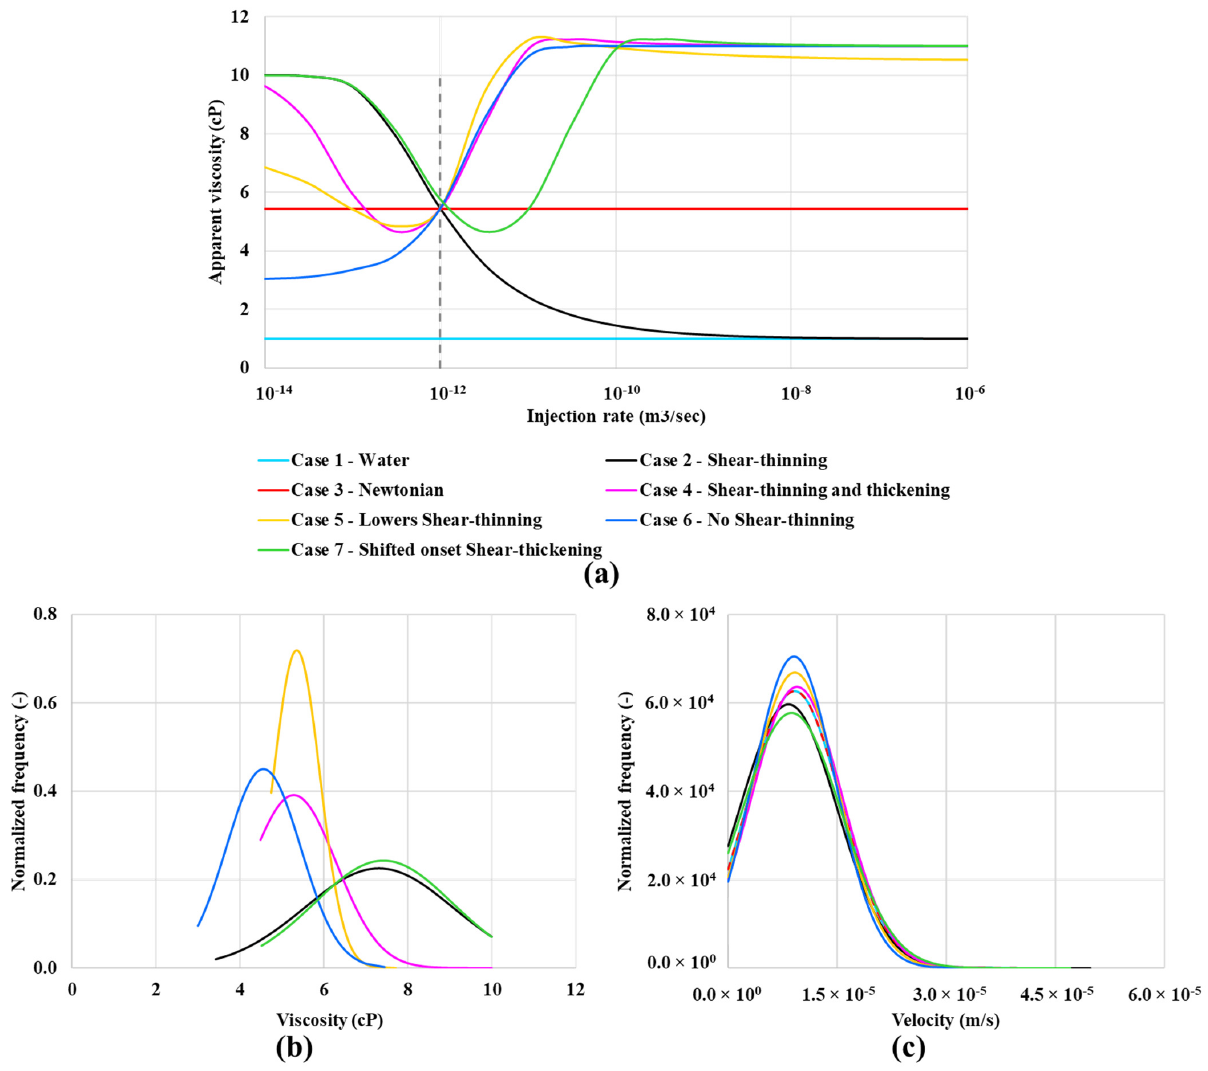
Figure 4. ( a ) in-situ rheology of water and six “polymer” solutions, ( b ) viscosity distribution at an injection rate of 1 × 10 − 12 m 3 /s and ( c ) corresponding velocity distribution, all in a single phase flow.